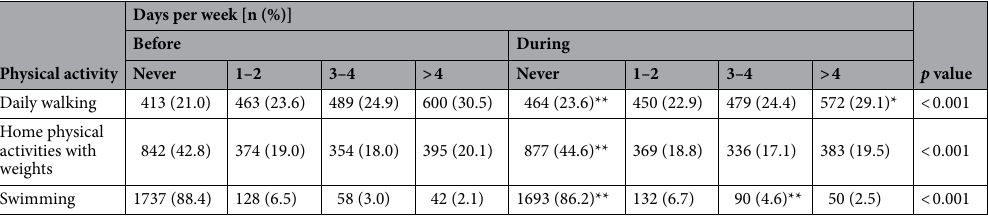
Table 3. Responses to the physical activity questionnaire recorded before and during home quarantine. Data presented n (%). * and ** represented p value significant at < 0.05 and 0.01 level using Cochran’s Q test and McNemar’s test.